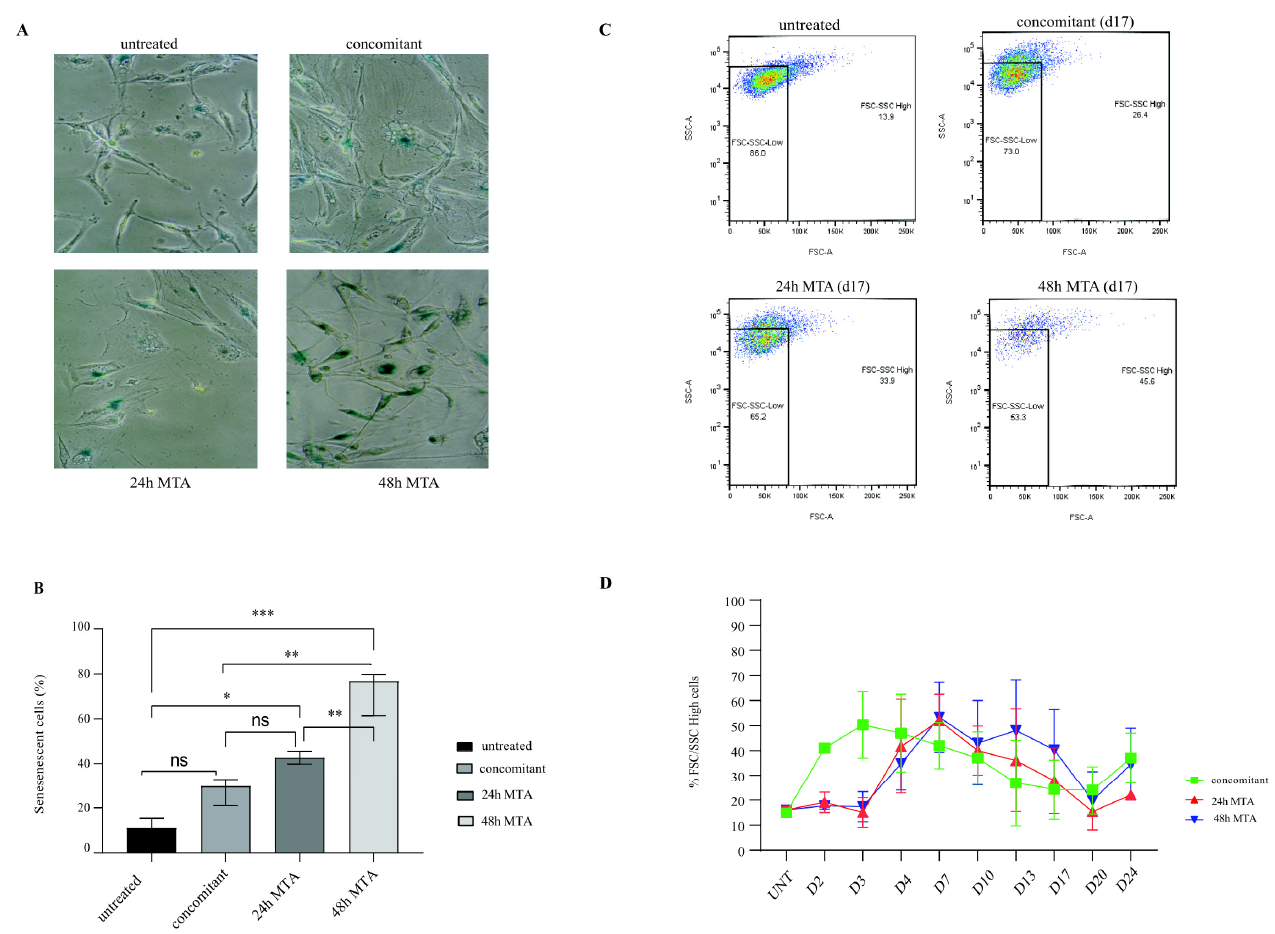
Figure 2. Prolonged MTA pretreatment exacerbates cisplatin-induced senescence induction. ( A ) Representative images of cell cultures taken by phase contrast-based microscopy after they were harvested on day 10 and allowed to regrow for 5 days. Blue staining indicates cells, which stain positive for senescence-associated β -galactosidase activity. ( B ) Quantification of senescent cells based on increased β -galactosidase activity. Data represent the means of three independent experiments, and bars indicate means and standard deviations. Two-way ANOVA was used to compare different treatment groups (ns p > 0.05 (not significant), * p < 0.05, ** p < 0.01, and *** p < 0.001). ( C ) Forward and side scatter analysis by flow cytometry at day 17 of the recovery phase. ( D ) Quantification of flow cytometry data over time. Data represent the means of three independent experiments, and bars indicate standard deviations.